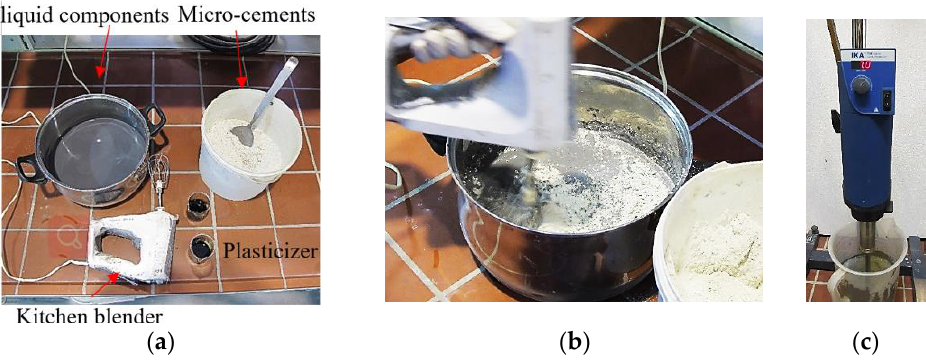
Figure 1. Preparation of the impregnation suspension: ( a ) the liquid and solid components, including the two parts of the plasticizer and the ready-to-use kitchen blender; ( b ) initial homogenization with the kitchen blender; and ( c ) final homogenization with the high-speed mixer.